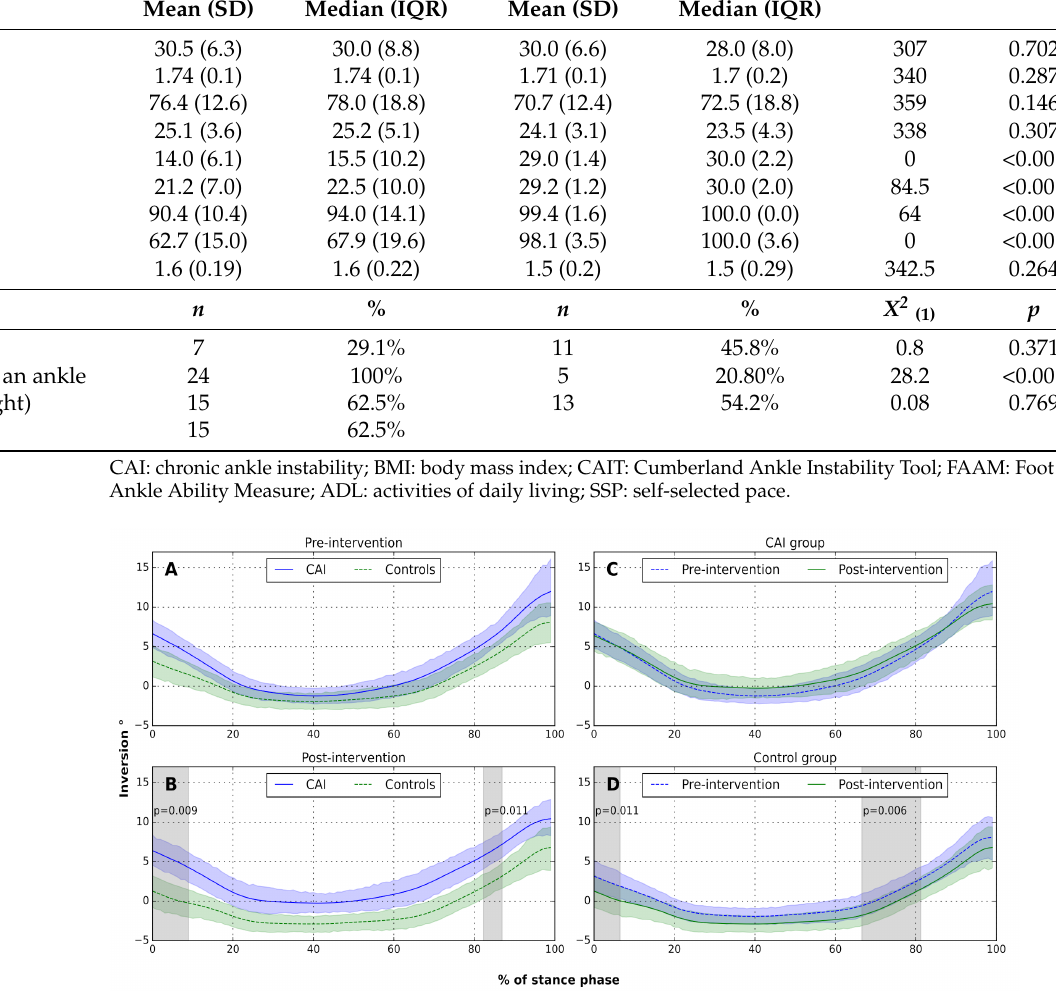
Figure 2. Between- and within-group comparisons of ankle inversion ankle during the stance phase of gait: ( A ) before intervention, between groups; ( B ) after intervention, between groups; ( C ) CAI group, pre/post-intervention; ( D ) control group, pre/post-intervention. Solid and dashed lines represent group means. Green and blue shaded areas represent 95% confidence intervals of the mean, at each data point. Gray shaded areas represent significant differences according to SPM analysis ( p < 0.0125, due to Bonferroni